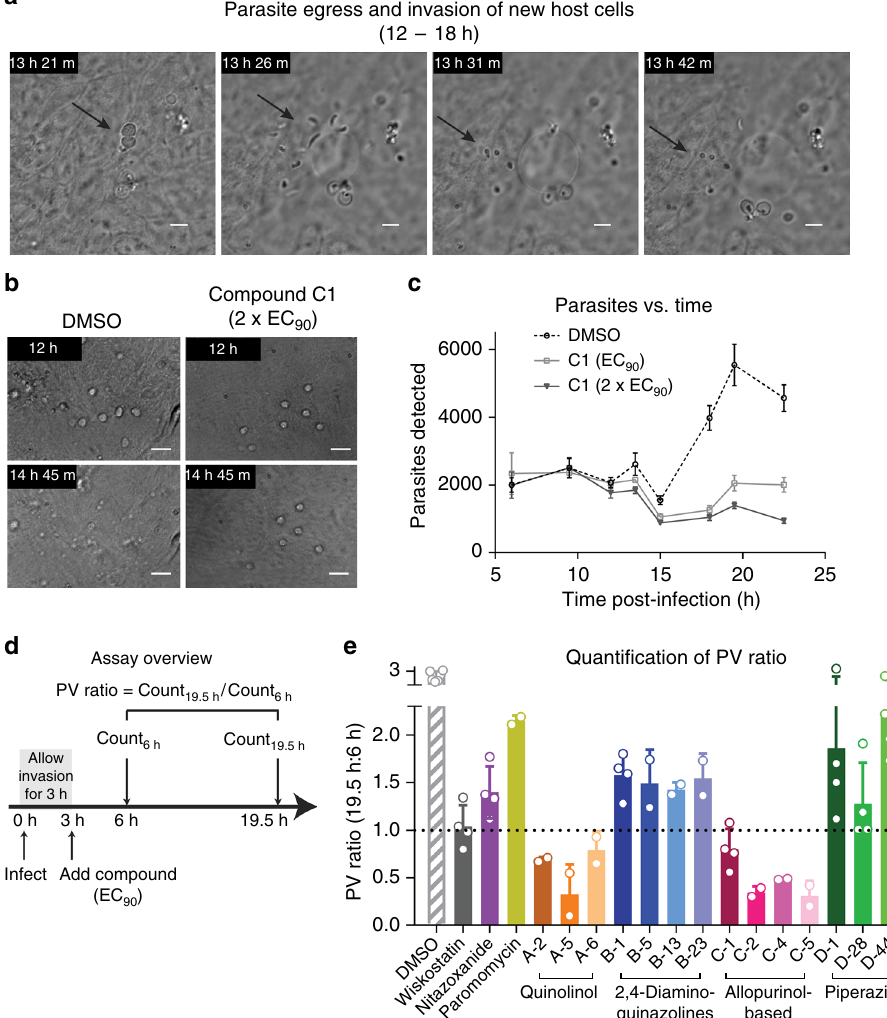
Fig. 4 Assay to measure parasitophorous vacuole (PV) egress and invasion of new host cells. a Time-lapse microscopy showing the rapid events of PV egress to release motile merozoites that invade neighboring HCT-8 cells. 60 × oil objective (NA = 1.4); scale = 5 µ m. b Time-lapse microscopy of C. parvum PVs in the presence of allopurinol-based compound C-1 (MMV403679) at 2 × EC 90 (1.3 µ M) or the matched DMSO control. 40 × dry objective (NA = 0.7); scale = 10 µ m. c Time course infection experiment in the presence of DMSO or the allopurinol-based compound C-1 at EC 90 or 2 × EC 90 . The graph shows PV numbers versus time for each condition. Data points are mean and SD, n = 4, representative of three independent experiments. d Outline of the experimental method for improved assay throughput. Infected HCT-8 cells were treated with EC 90 of compounds 3 h after infection and PV numbers were determined at 6 h (i.e., before egress), and at 19.5 h (i.e., after egress) by immuno fl uorescence microscopy and an ImageJ macro. The PV ratio (count 19.5h / count 6h ) is used as the assay readout. e Graph showing PV ratios for selected controls and the test set of compounds. All compounds reduced the PV ratio compared to DMSO, but to varying degrees and with good agreement within each chemical series. Data combined from at least two independent experiments (six for DMSO control) with four technical replicates each, mean and SD shown. Source data are provided as a Source Data fi